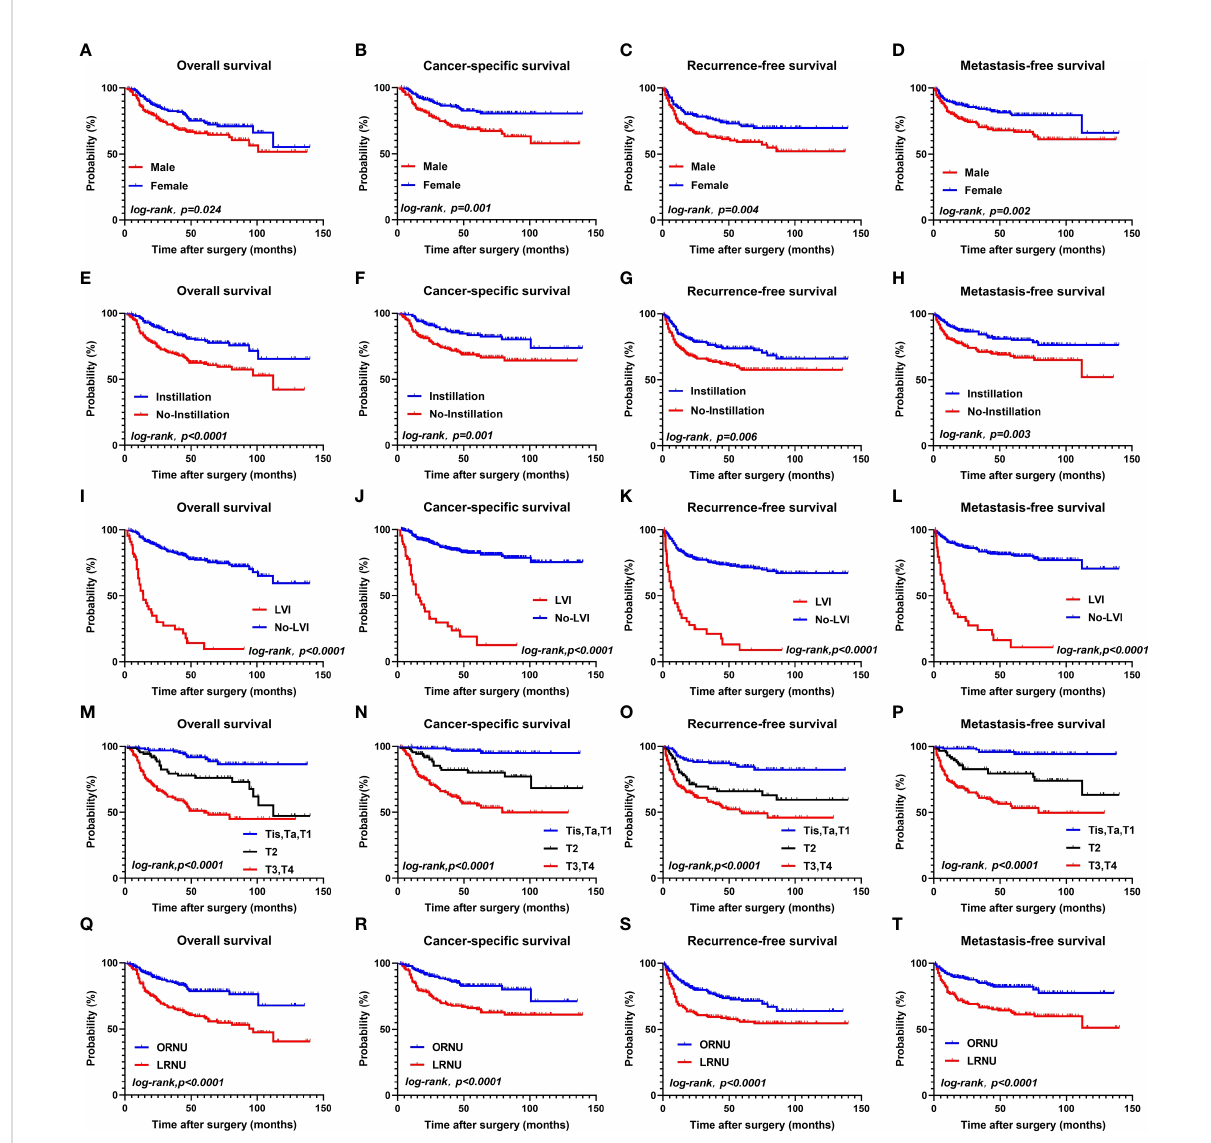
FIGURE 1 OS, CSS, RFS, MFS between the female group and male groups (A – D) ; OS, CSS, RFS, MFS between the instillation group and the No-instillation groups (E – H) ; OS, CSS, RFS, MFS between the LVI group and the No-LVI groups; (I – L) ; OS, CSS, RFS, MFS between the Tis, Ta, T1 group and T2 group, T3-T4 group (M – P) ; OS, CSS, RFS, MFS between the ORNU group and LRNU groups (Q – T)